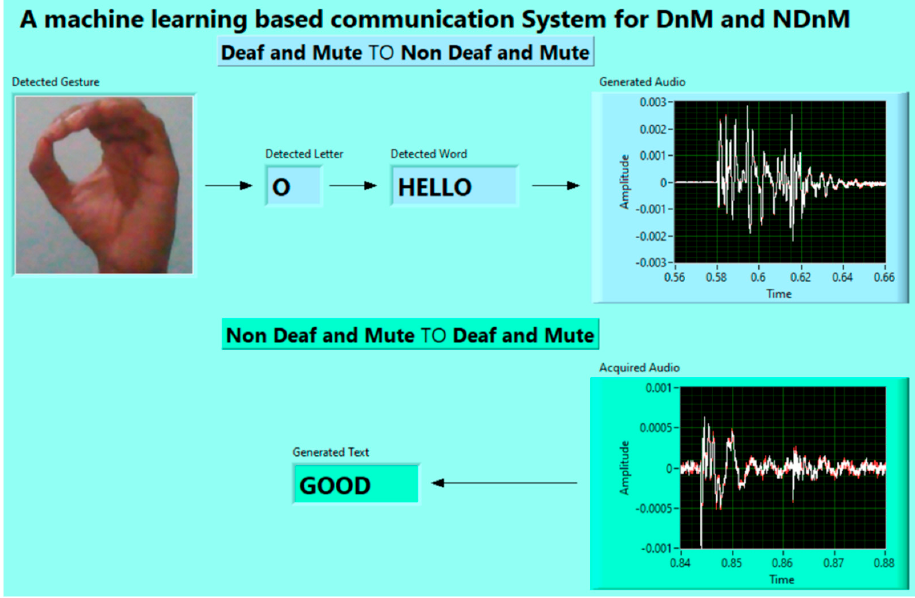
Figure 7. Software Application Screenshot.